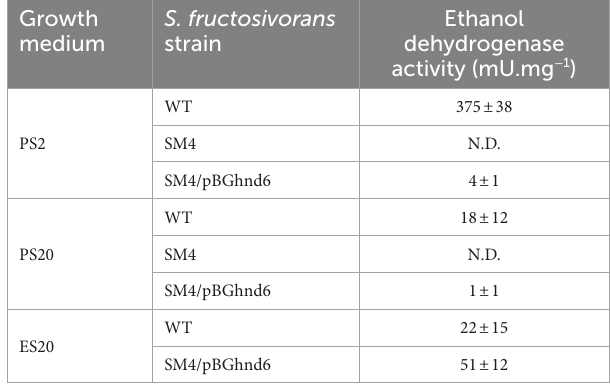
TABLE 2 Ethanol dehydrogenase activity in S. fructosivorans